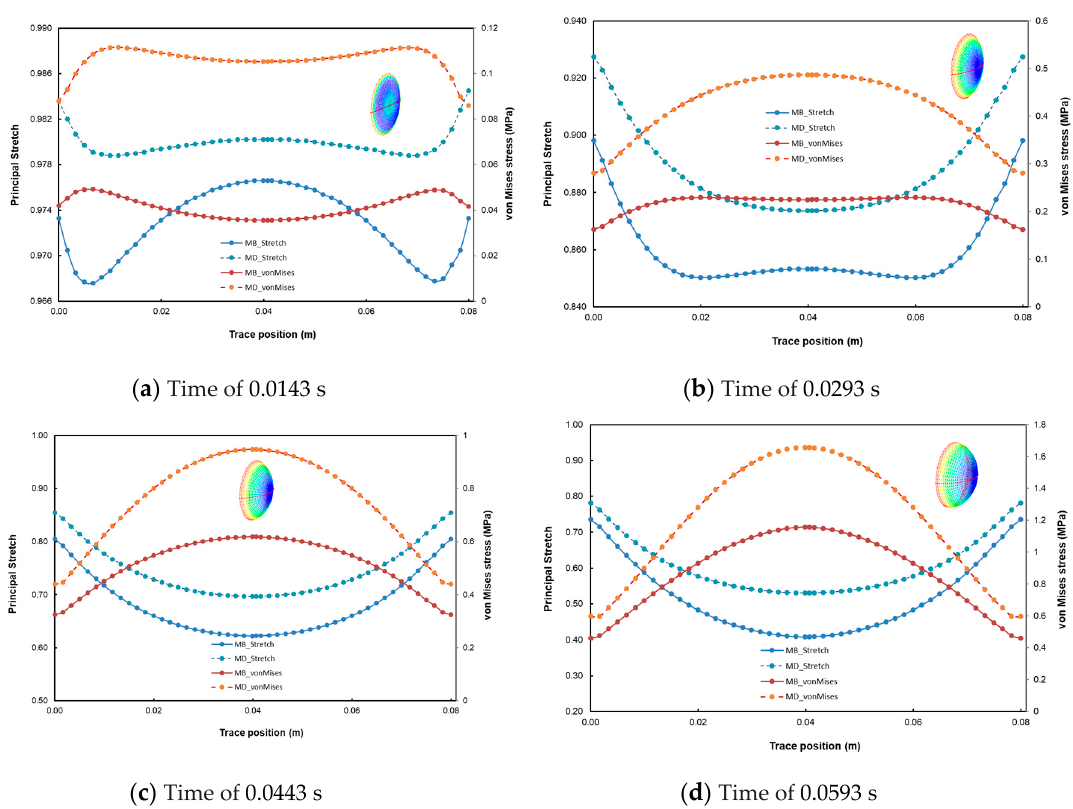
Figure 12. Transient evolution of the principal stretch and von Mises stresses at different instants: